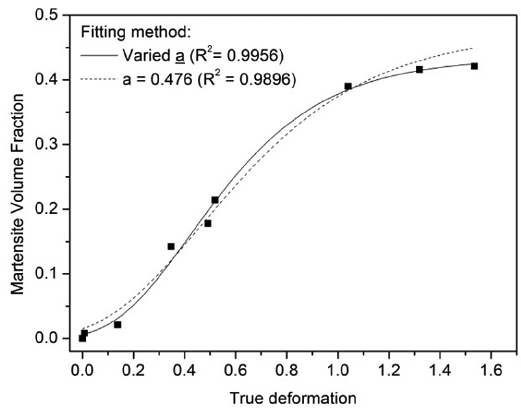
Figure 8. Curves of models for martensite volume fraction as function of true